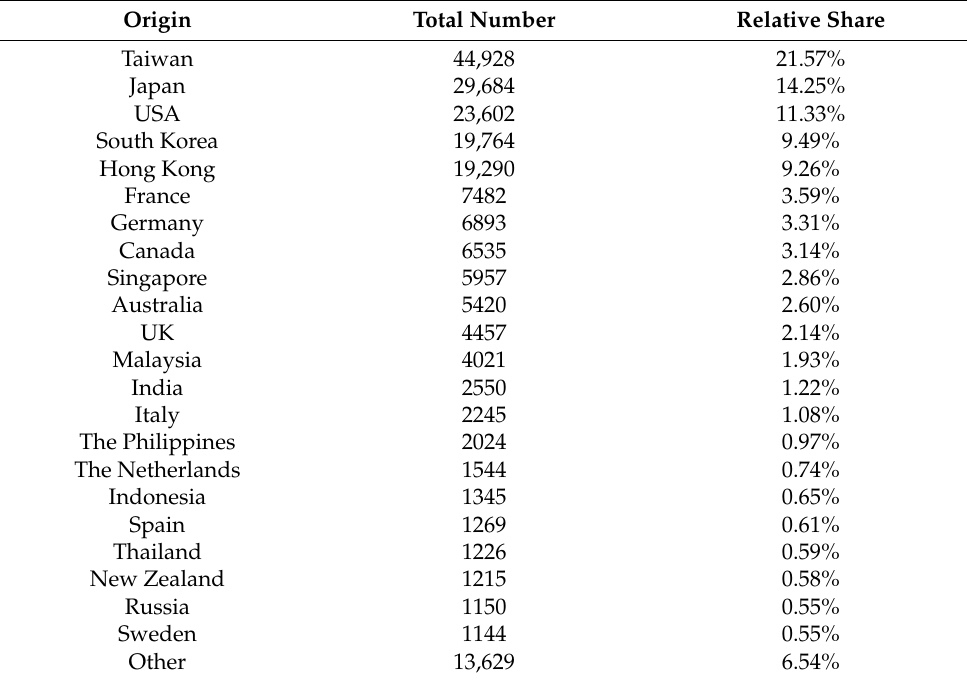
Table 1. Largest groups of international residents in Shanghai by nationality in